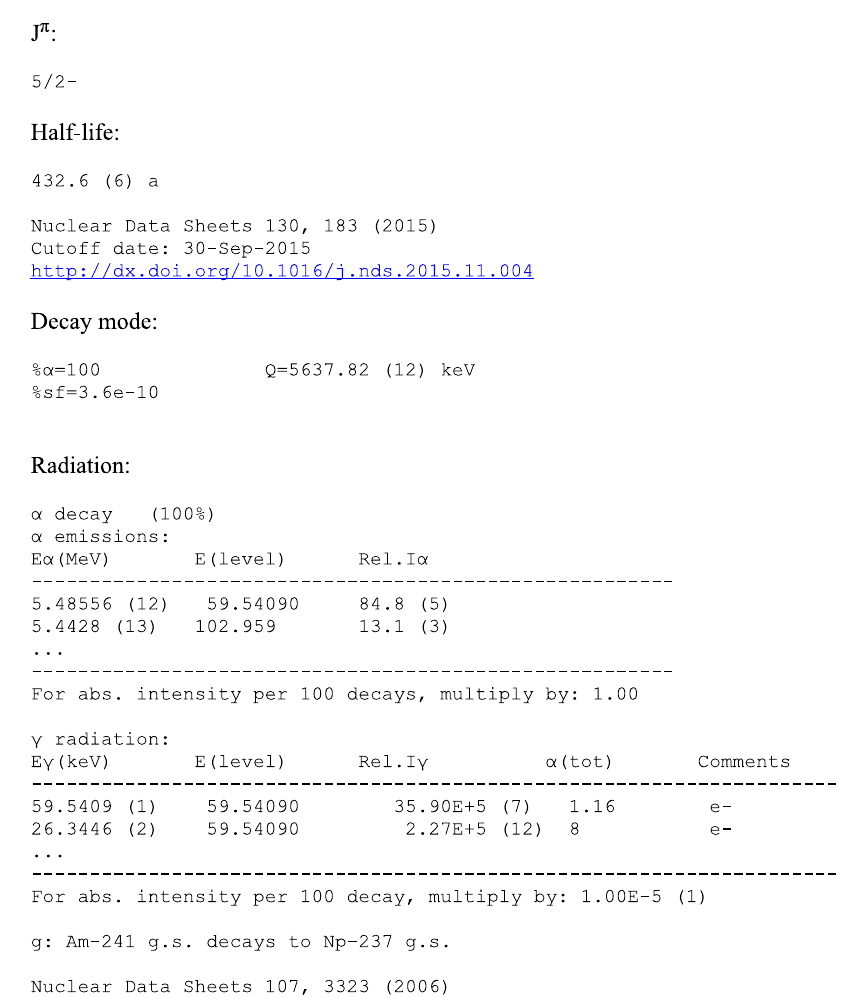
Fig. 5. References for decay data for individual nuclides are available in the online version of the Karlsruhe Nuclide Chart. In this example for Am 241 note the data sources for half-life and decay modes/radiations are from different NDS